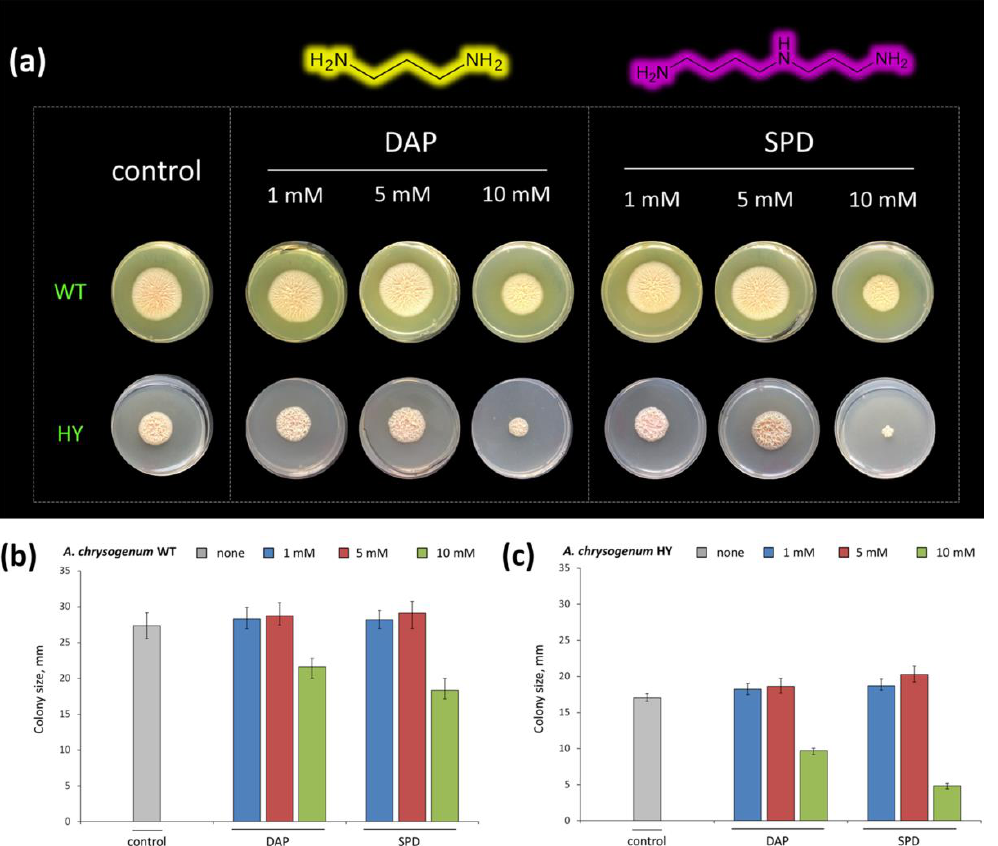
Figure 2. Growth of A. chrysogenum wild-type (WT) and high-yielding (HY) strains on agarized Czapek–L-Asn medium, supplemented with 1,3-diaminopropane (DAP) or spermidine (SPD)—both at the concentration of 1 mM, 5 mM, or 10 mM, or without additions (control). Cultivation for 20 days at 26 ◦ C. ( a ) Phenotype on different media; ( b ) colony diameter size of A. chrysogenum WT strain, mm; ( c ) colony diameter size of A. chrysogenum HY strain,